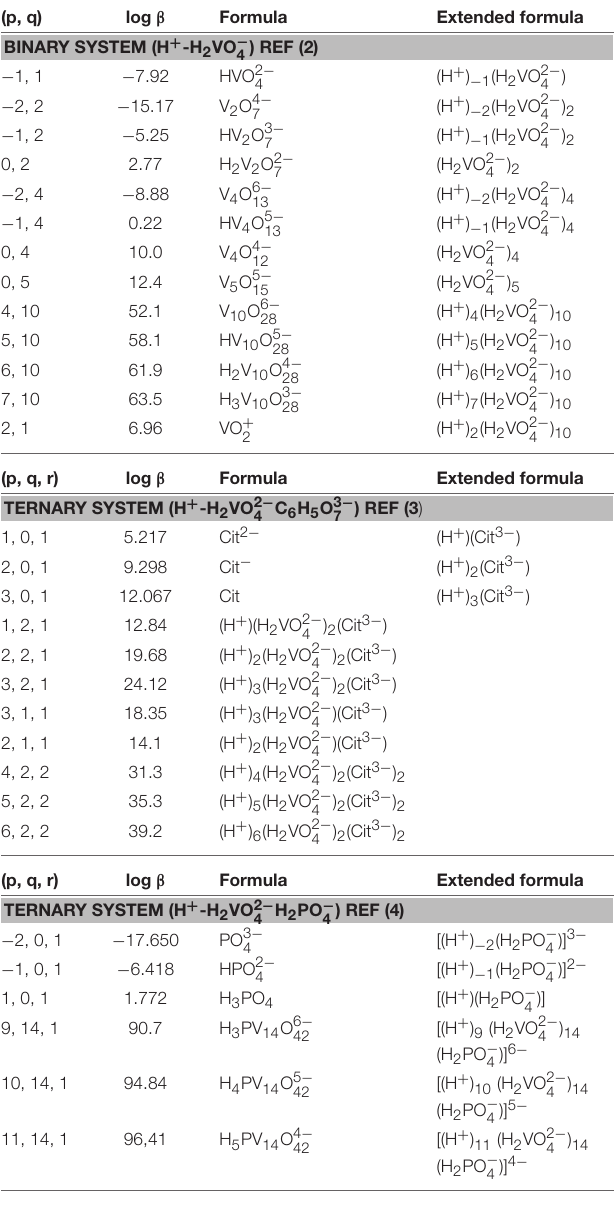
TABLE 1 | Formation constants of Vanadate species in a 0.6M NaCl system. (p, q) log β Formula Extended